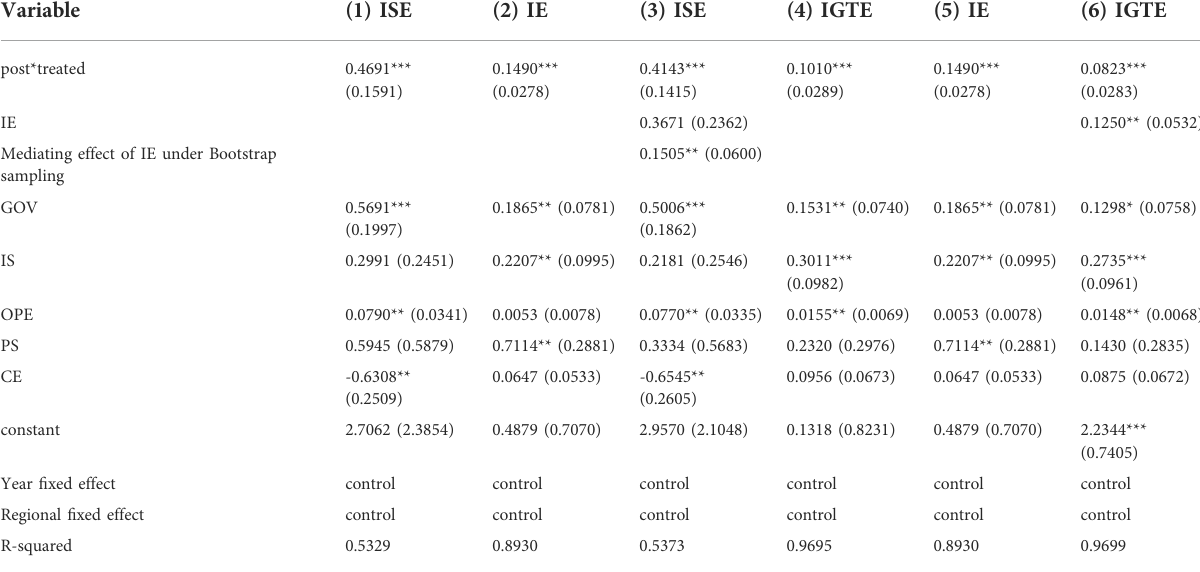
TABLE 7 Mediating effect of innovation environment level.